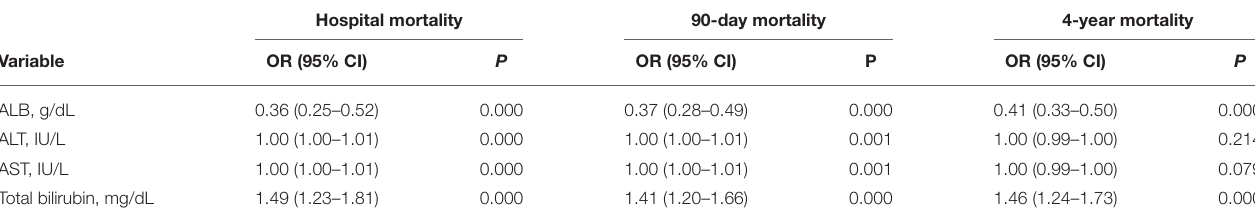
TABLE 6 | Univariate logistic regression analyses for prognosis in cardiac surgery patients without liver disease. Hospital mortality